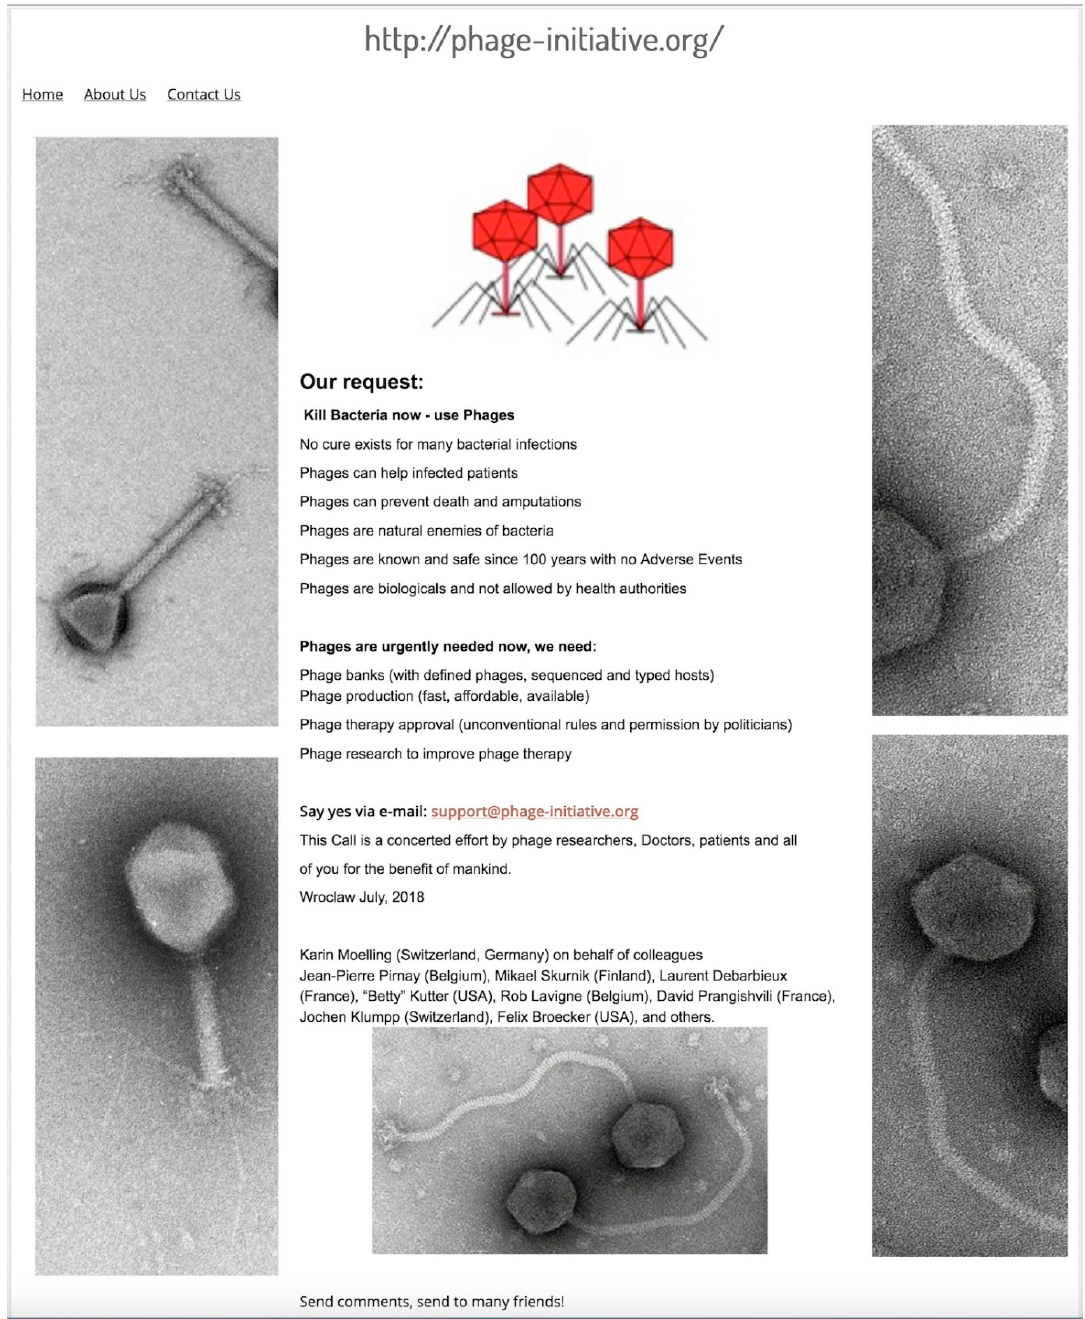
Figure 4. Screenshot of the website http://phage-initiative.org/. Please send an e-mail to: Figure